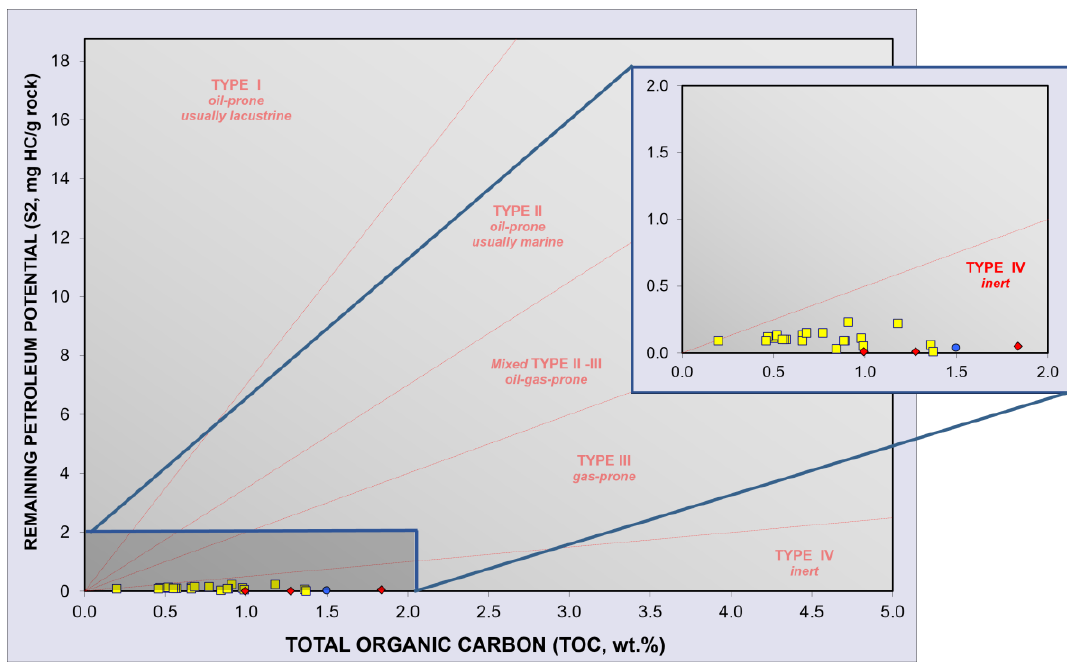
Figure 4. Relationship between petroleum potential and TOC (based on Langford and Blanc-Valleron [17]). Yellow squares representing Brejeira Fm., red diamonds Mira Fm., and blue circle Mértola Fm.